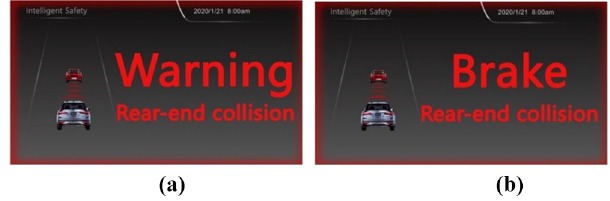
Figure 7 demonstrated the vehicle movements characteristics and vehicle interaction characteristics before and after the pedal force of SV, the average TH and TTC. The two-time rst brake was painted as light and dark grey, respectively.